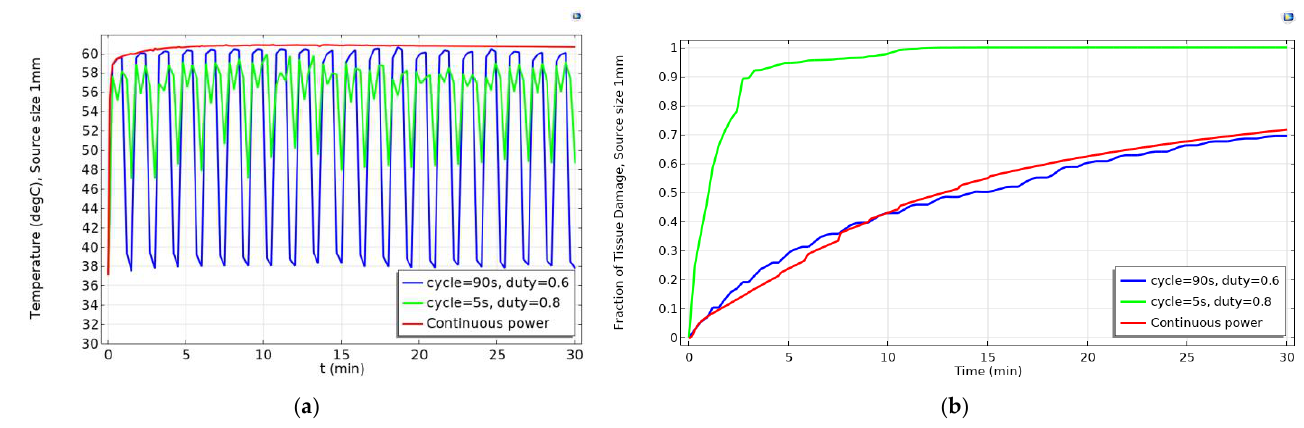
Figure 3. The change in ( a ) the temperature and ( b ) the fraction of tissue damage at the source diameter of 1 mm with pulsed powers during the 30-min simulation.